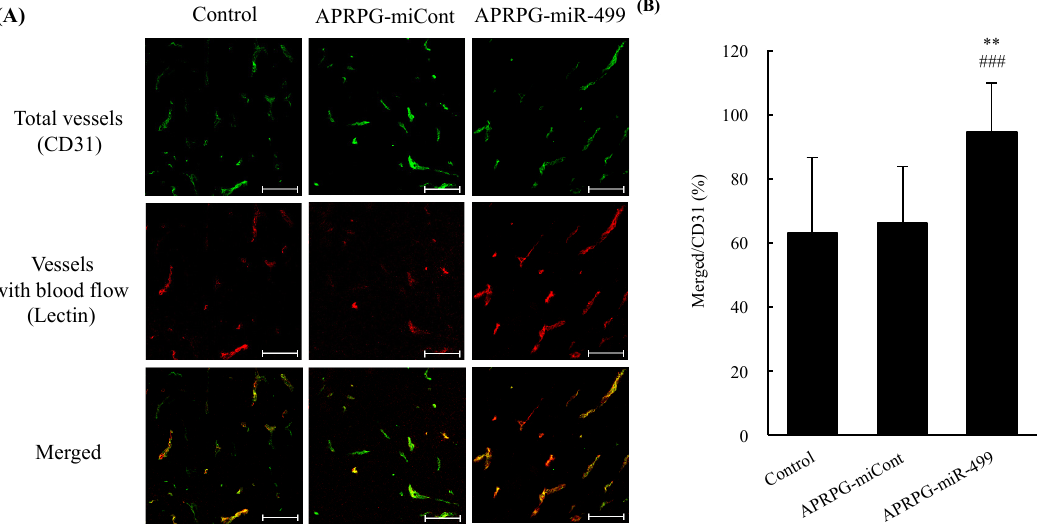
Figure 1. miR ‐ 499 ‐ mediated improvement of blood flow in tumor blood vessels. Colon 26 NL ‐ 17 cells were subcutaneously implanted into the left posterior flank of BALB/c mice. APRPG ‐ miR ‐ 499 or APRPG ‐ miCont (2 mg/kg as miRNA) were administered intravenously seven days after the implantation. Perfused vessels were labeled by intravenous injection of biotin ‐ conjugated Lycopersicon esculentum Lectin at 96 h after the lipoplex injection. The tumor vessels were fixed by reflux flow with 1% paraformaldehyde. After the solid tumors had been dissected, 10 ‐μ m frozen sections were prepared. CD31 of the vasculature was immunostained with FITC. Biotin ‐ conjugated Lycopersicon esculentum Lectin was labeled with Streptavidin ‐ Alexa Fluor ® 594. Green indicates vasculature, red indicates vessels with blood flow. Yellow color indicates areas of double ‐ stained vessels. ( A ) Confocal images are shown. Scale bars indicate 100 μ m; ( B ) Percent lectin + CD31 + double ‐ positive area/total CD31 + area was determined to assess perfusion efficiency of the tumor vasculature. Data are presented as percent ratio of merged area/CD31 + area. Asterisks indicate significant differences (** p < 0.01 vs. control, ### p < 0.001 vs. APRPG ‐ miCont).